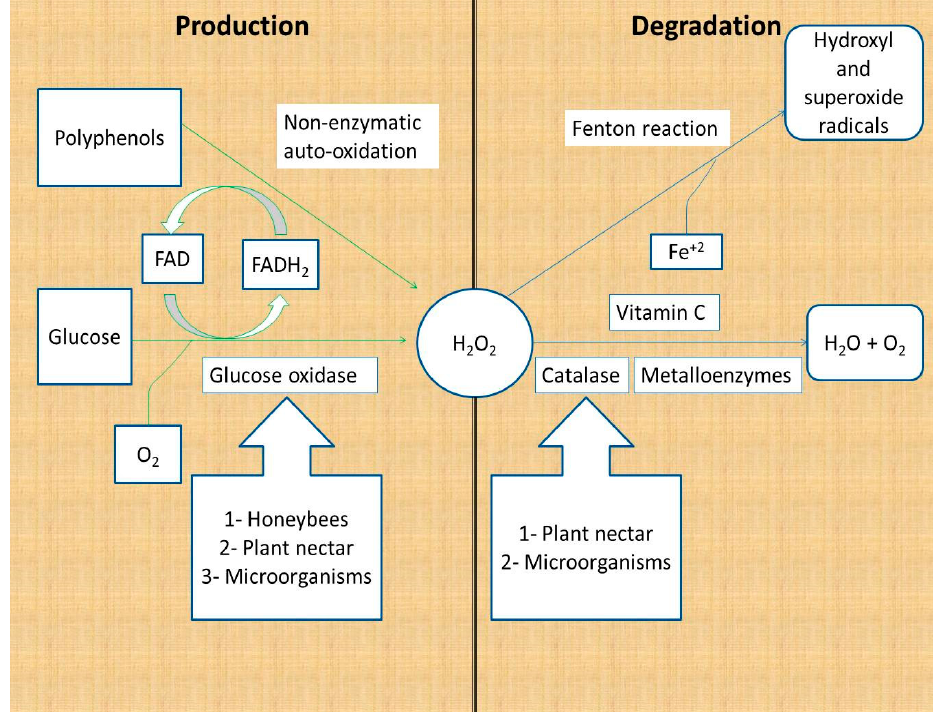
Figure 1. Production and degradation of hydrogen peroxide in honey. Hydrogen peroxide is produced from glucose by the action of glucose oxidase and non-enzymatically by polyphenols. Hydrogen peroxide is degraded to water and oxygen by enzymes and vitamin C, whereas it is degraded to hydroxyl and superoxide radicals through the Fenton reaction